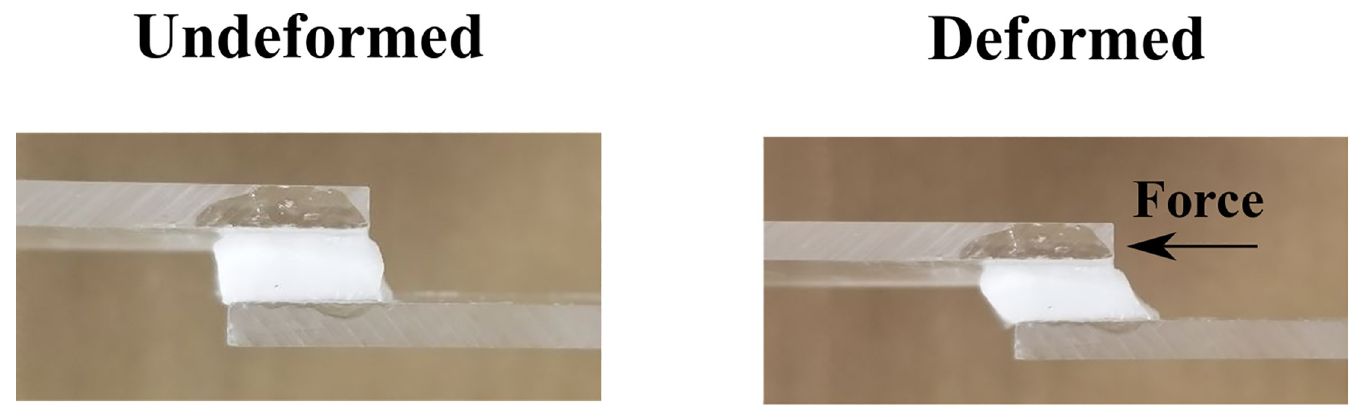
Fig 3. The loading configuration for the shear relaxation tests. The cuboid was subjected to 50% shear strain and left to relax for 300 seconds.